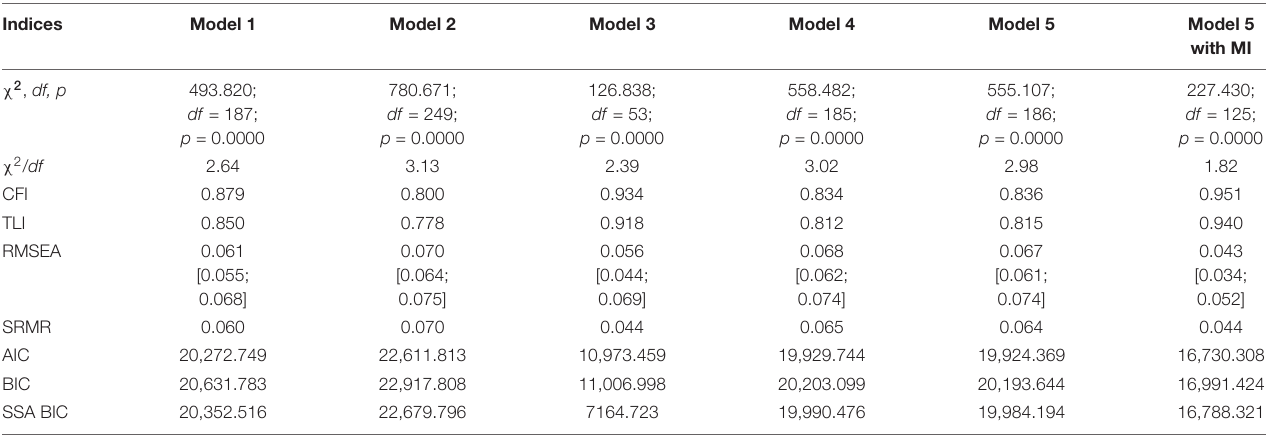
TABLE 2 | Confirmatory factor analyses: fit indices for the five models